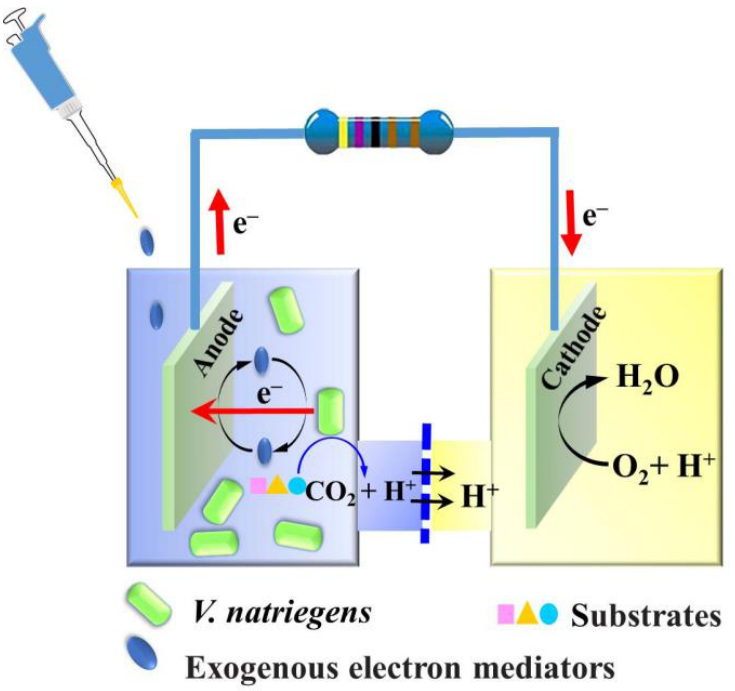
Figure 2. Schematic representation of V. natriegens MFC used in this study.